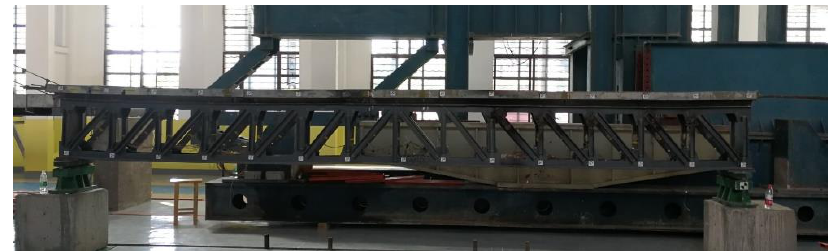
Figure 4. Illustration of the test beam with dimensions (units: mm).